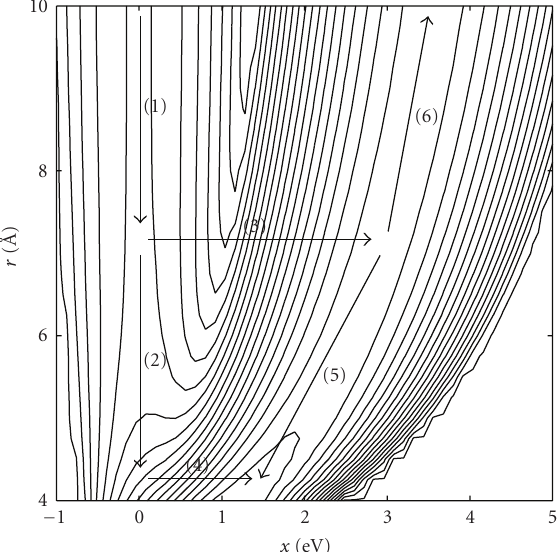
Figure 5: Contour plot of Figure 4(b). The arrows show the typical processes involved in fluorescence